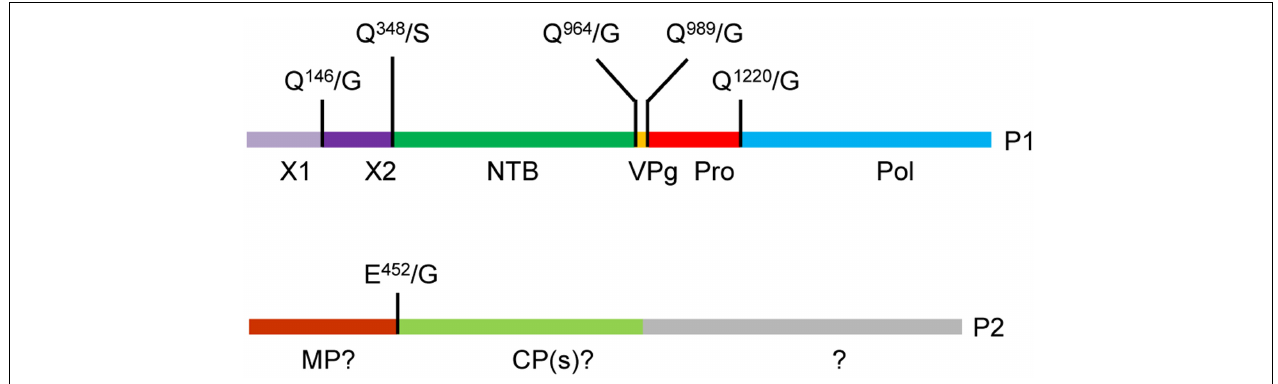
FIGURE 6 | Updated genomic organization of strawberry mottle virus isolate NsPer3. The P1 and P2 polyproteins are depicted showing experimentally confirmed cleavage sites with vertical lines. Abbreviations and numbering are as described in Figure 1